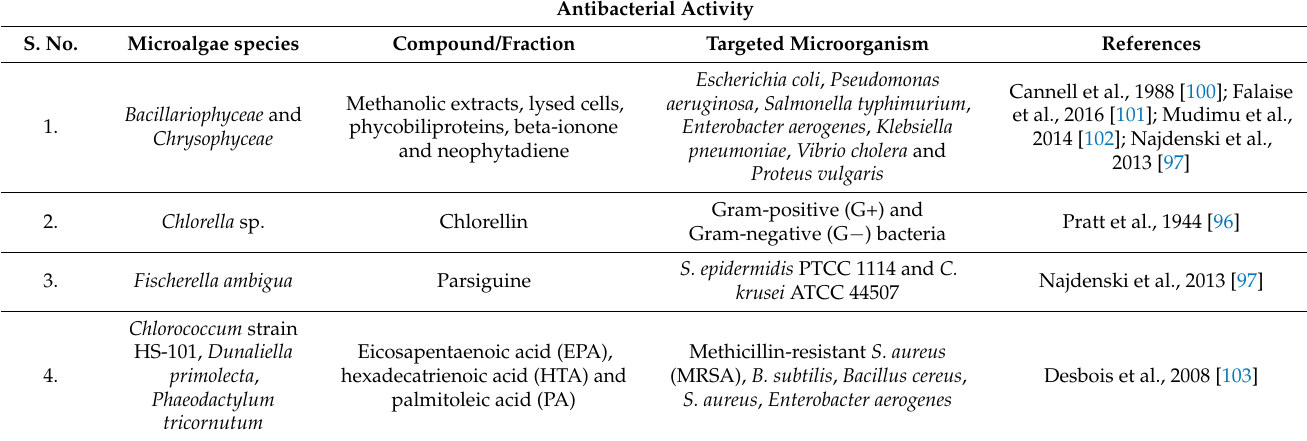
Table 2. Biological extracts and therapeutic applications of different microalgal species against human